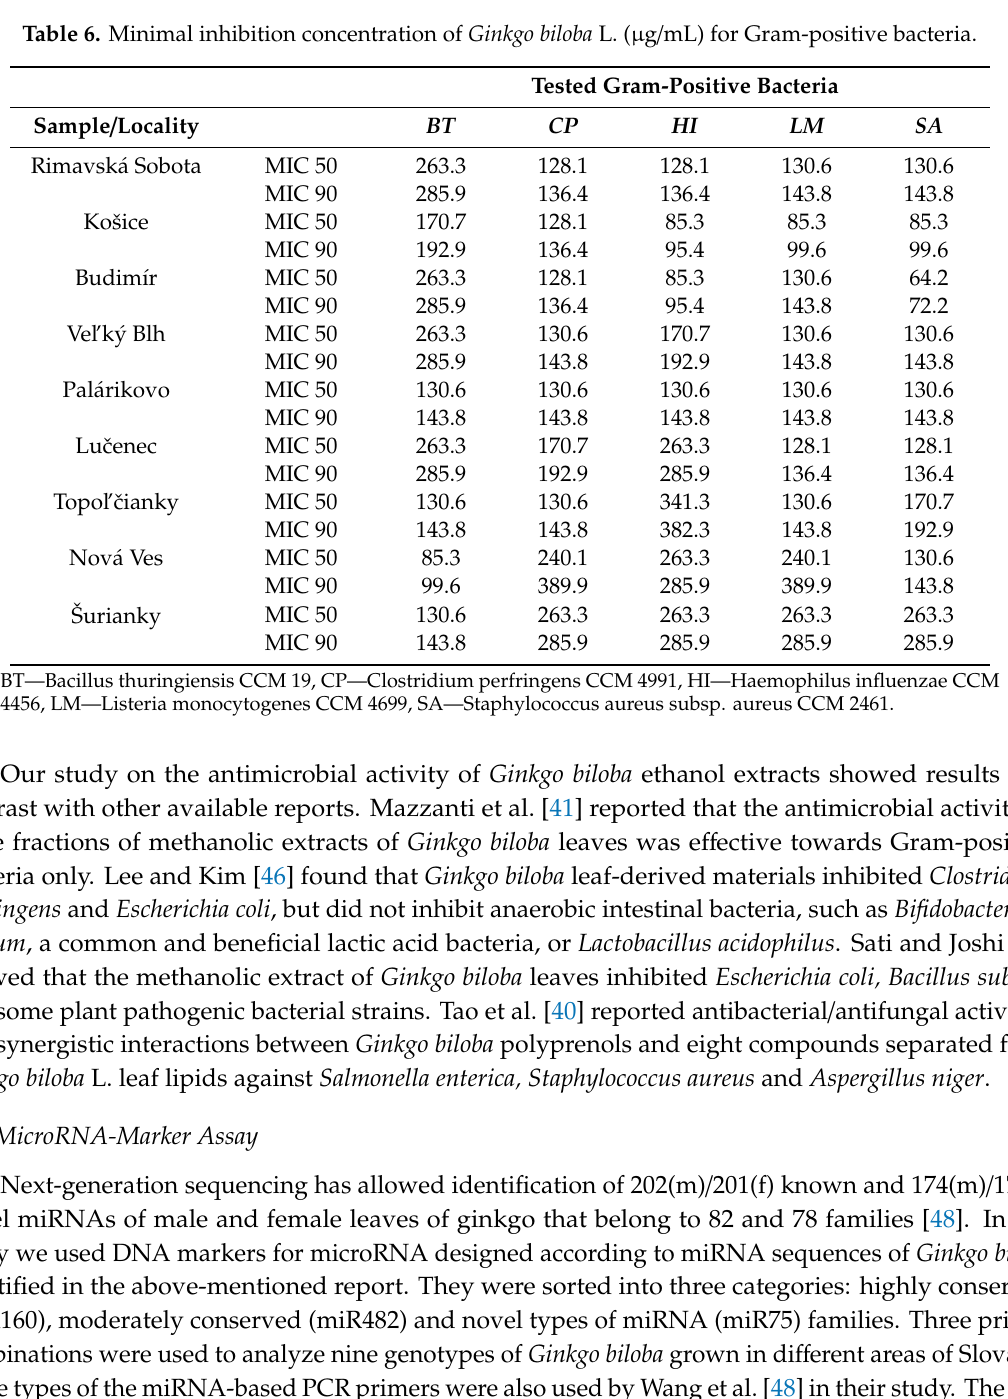
Table 6. Minimal inhibition concentration of Ginkgo biloba L. ( µ g / mL) for Gram-positive bacteria. Sample /